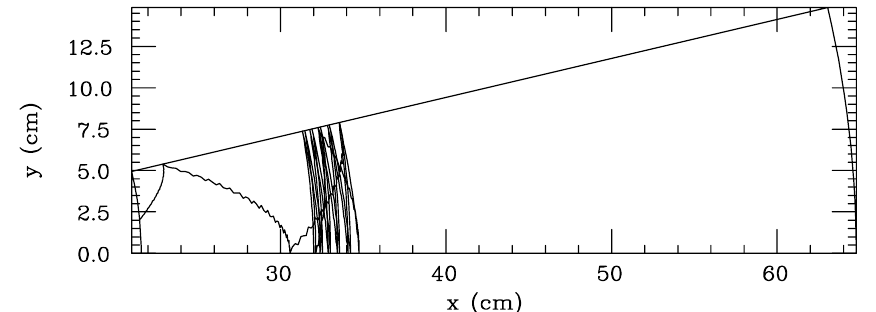
FIG. 7. Trajectory of an electron launched at a radius of 32 cm in wedgeguide and temporarily experiencing almost balanced transverse forces, eventually migrating to a sidewall and performing successive low energy impacts to reduce secondary multiplication to , 10 2 3